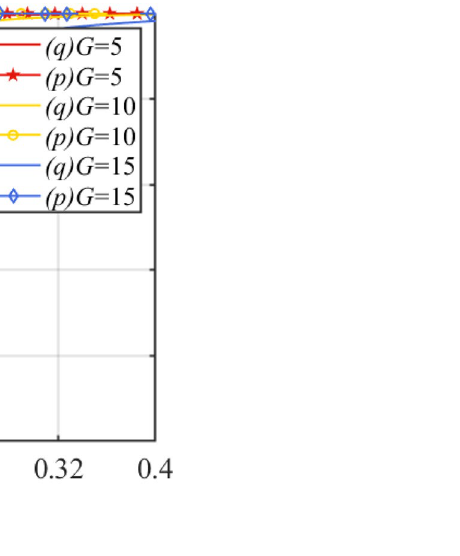
Figure 4. Effect of parameter G